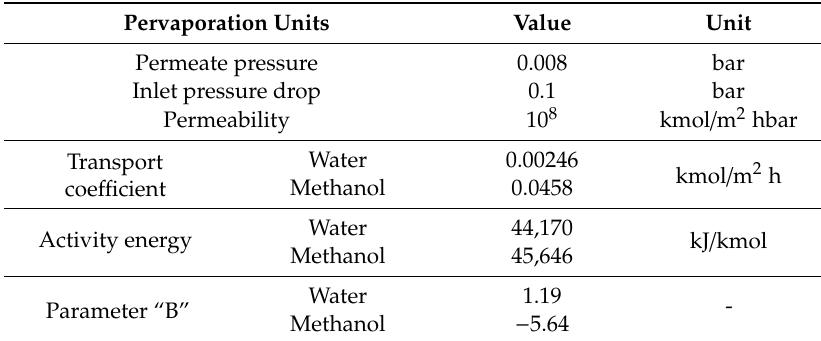
Table 5. Organophilic pervaporation membrane parameters of methanol-water mixture (PERVAP ™ 4060 type membrane) [76].